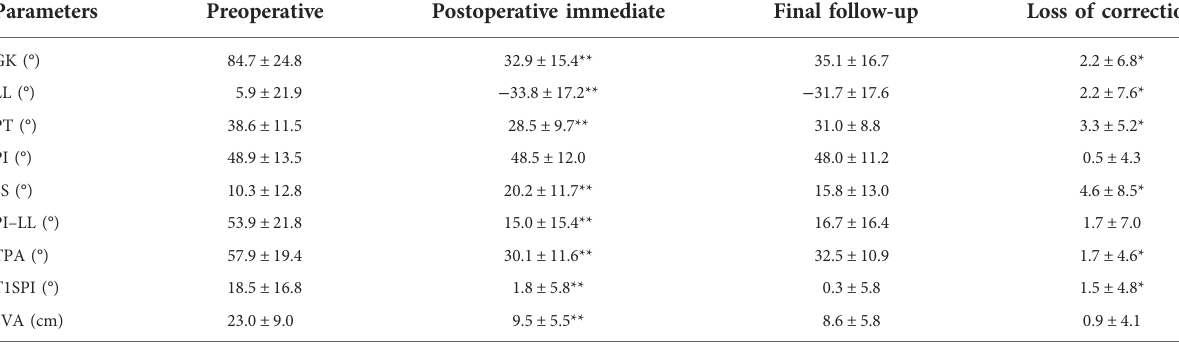
TABLE 1 Differences of radiographic parameters in ankylosing spondylitis patients after